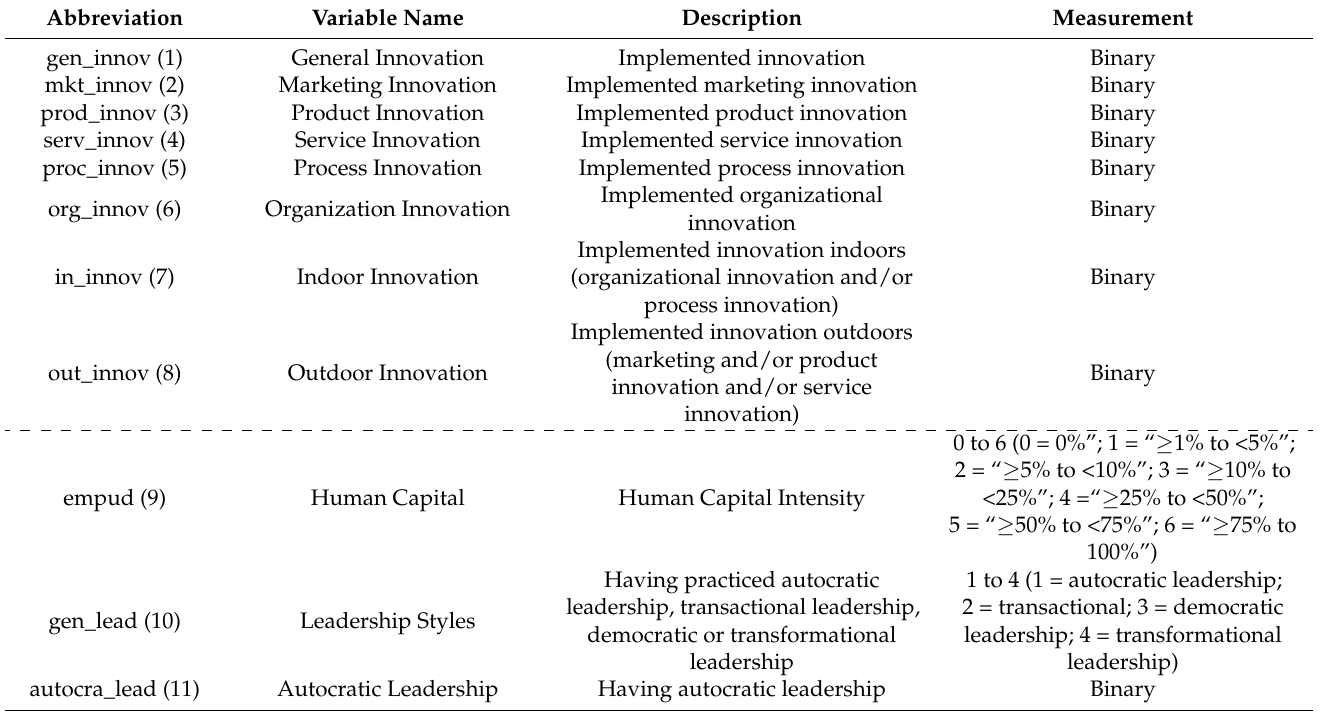
Table 1. Description of